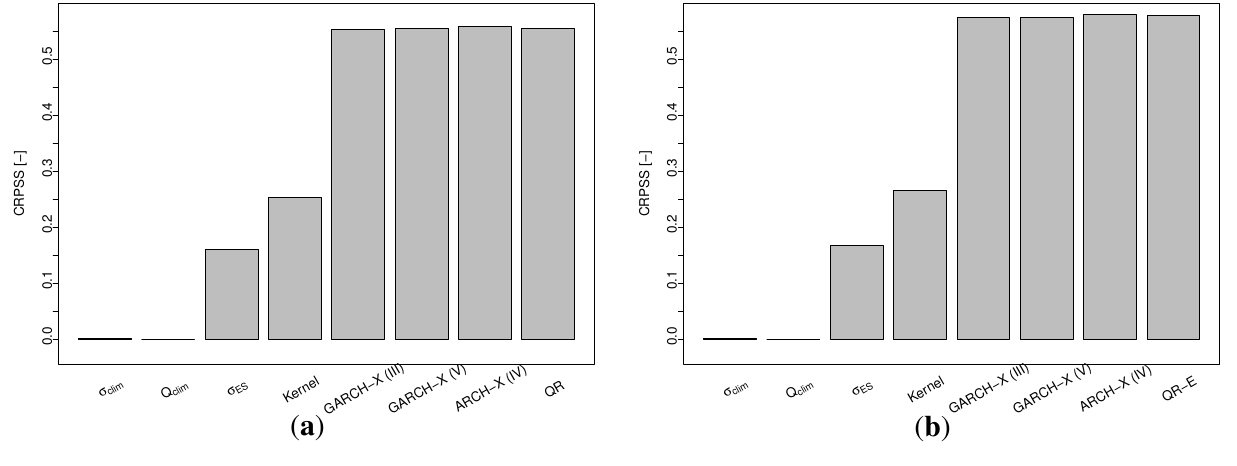
( a ) and τ ∈ τ ( b 1 2